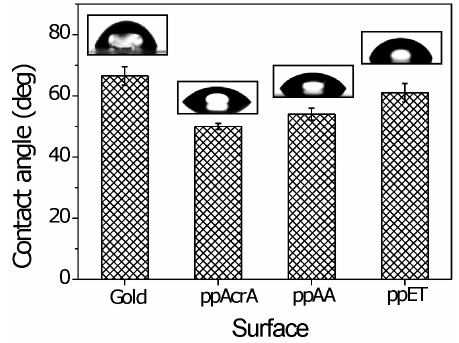
Figure 4. Static water contact angle of uncoated gold surface and pp coatings. Representative images of water droplets on three different samples are placed above the contact angle values. Measurements were made on five drops and averaged.